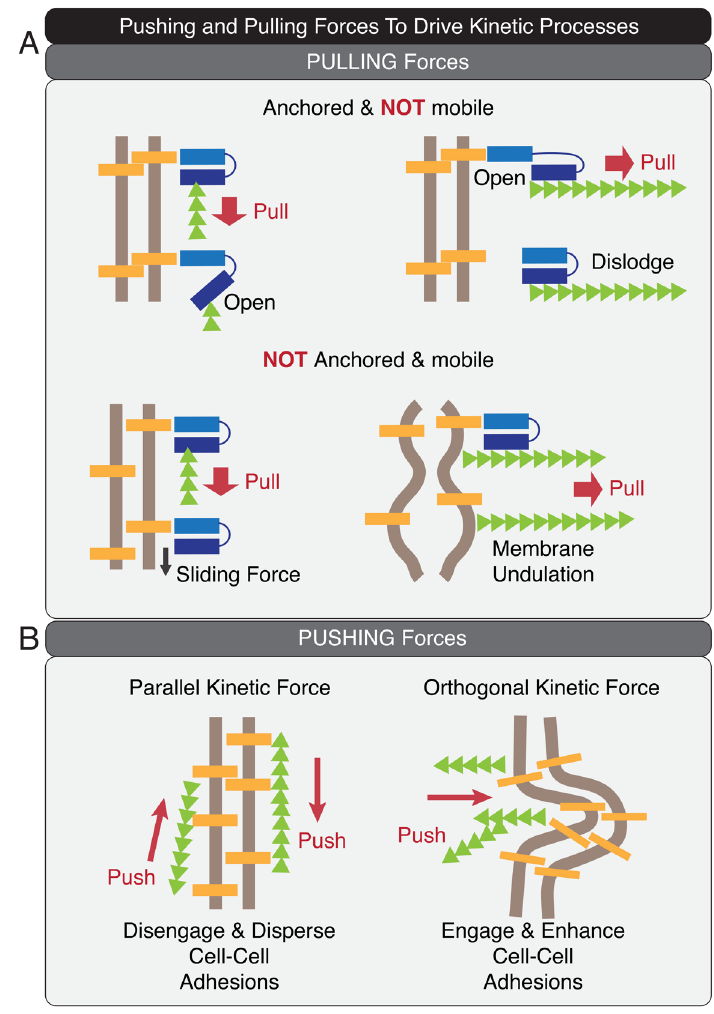
Figure 3. Pushing and pulling to drive kinetic processes. ( A ) Pulling on adhesions and membrane can break intra-molecular and inter- molecular bonds, cause movement of adhesions on the membrane, and create undulations on the cell–cell adhesion interface. ( B ) Pushing parallel to the lateral membrane can disengage and disperse adhesions, resulting in mixing of the membrane components. Pushing orthogonal to the lateral membrane can increase cell–cell contact area and time to enhance adhesion